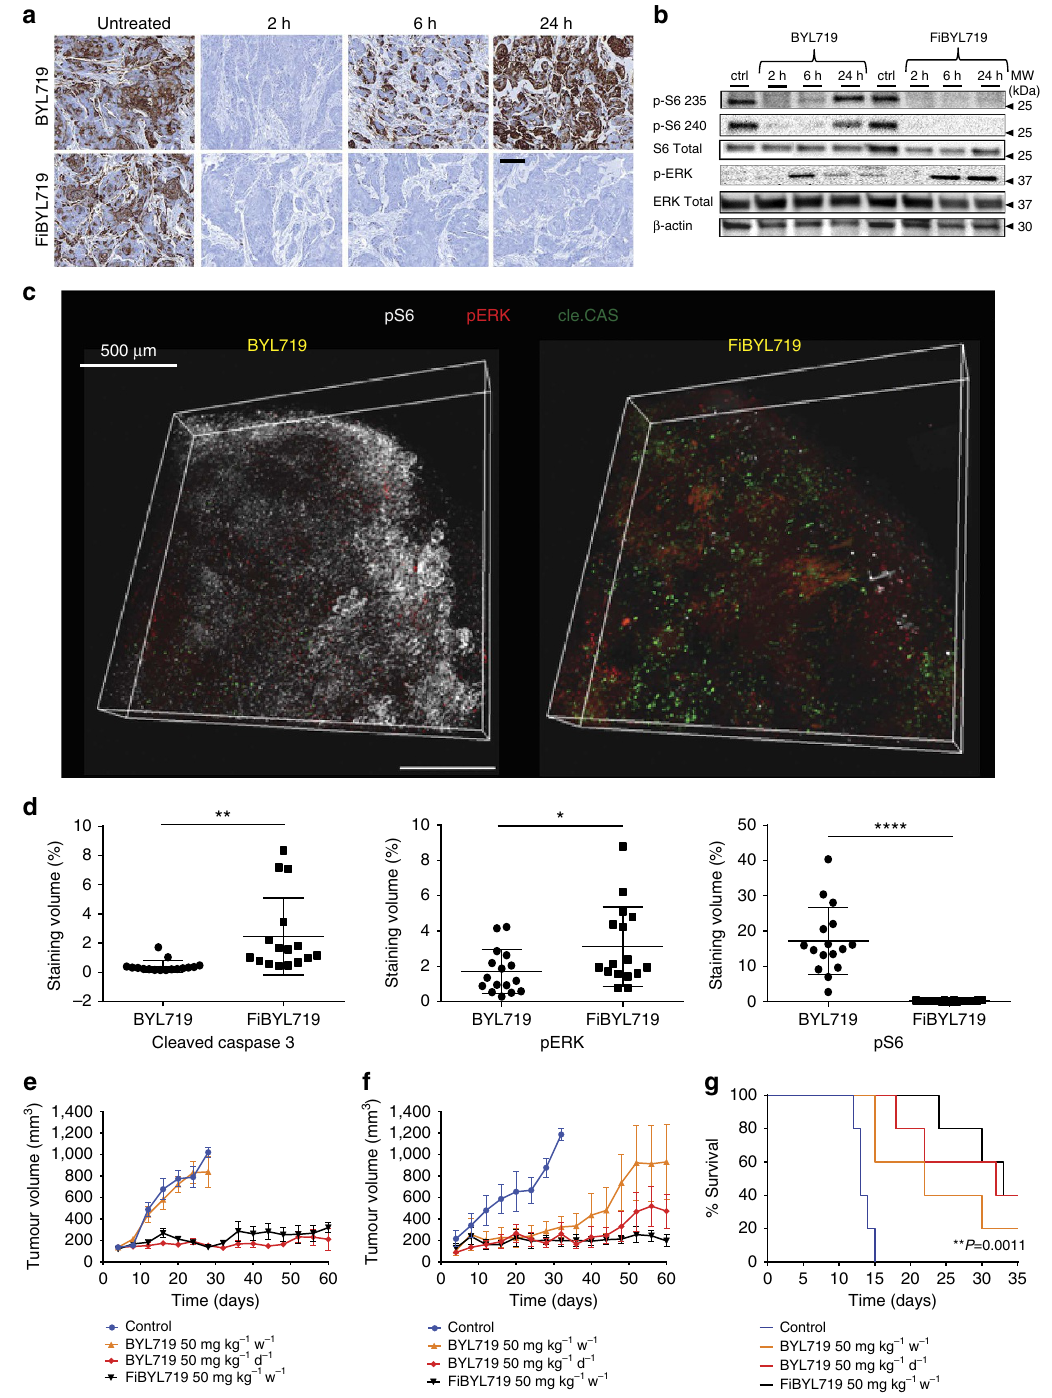
Figure 2 | Anti-tumour efficacy of free BYL719 and nanoparticle-encapsulated FiBYL719 in pre-clinical HNSCC models. ( a ) Representative images of immunohistochemistry staining for pS6 at different time points following treatment with 25mgkg (cid:2) 1 BYL719 or 25mgkg (cid:2) 1 FiBYL719 in Cal-33 xenografts ( n ¼ 3). Scale bar, 50 m m. ( b ) Western blot of pS6 and pERK in Cal-33 xenograft tissues following treatment with 25mgkg (cid:2) 1 BYL719 or 25mgkg (cid:2) 1 FiBYL719, n ¼ 3. ( c ) 3-D reconstruction of a stained Cal-33 xenograft section 24h after treatment with either 50mgkg (cid:2) 1 BYL719 or 25mgkg (cid:2) 1 FiBYL719. pS6 (white), pERK (red) and cleaved caspase 3 (green). Scale bar, 500 m m. ( d ) Box plots comparing the volume of positive staining (% of total tissue volume) of tissues shown in c , ( n ¼ 2). ( e ) Tumour growth curves of Cal-33 xenografts treated with oral administration of either 50 or 7mgkg (cid:2) 1 BYL719 daily, or i.v. injection of 25mgkg (cid:2) 1 FiBYL719 bi-weekly ( n ¼ 10). ( f ) Tumour growth curves of H22 patient-derived xenografts treated with oral administration of either 50 or 7mgkg (cid:2) 1 BYL719 daily, or bi-weekly i.v. injections of 25mgkg (cid:2) 1 FiBYL719 ( n ¼ 10). ( g ) Survival curve of mice engrafted with orthotopic tongue cal-33 xenografts treated with oral administration of either 50 or 7mgkg (cid:2) 1 BYL719 daily or i.v. injections of 25mgkg (cid:2) 1 FiBYL719 bi-weekly ( n ¼ 5). In d – f , error bars indicate mean ± s.e.m. * P o 0.05, ** P o 0.01, **** P o 0.0001; by one-way ANOVA with post hoc Tukey test. In g , P -value was calculated by using the log-rank